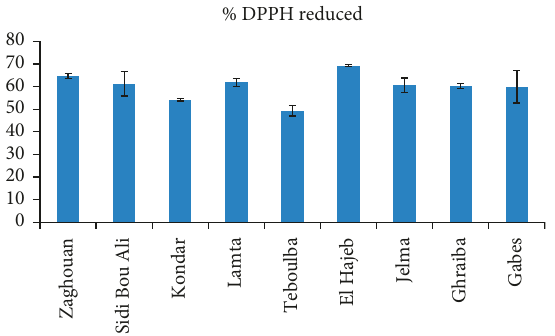
Figure 7: Radical-scavenging capacity of olive leaf extracts according to the cultivation regions.